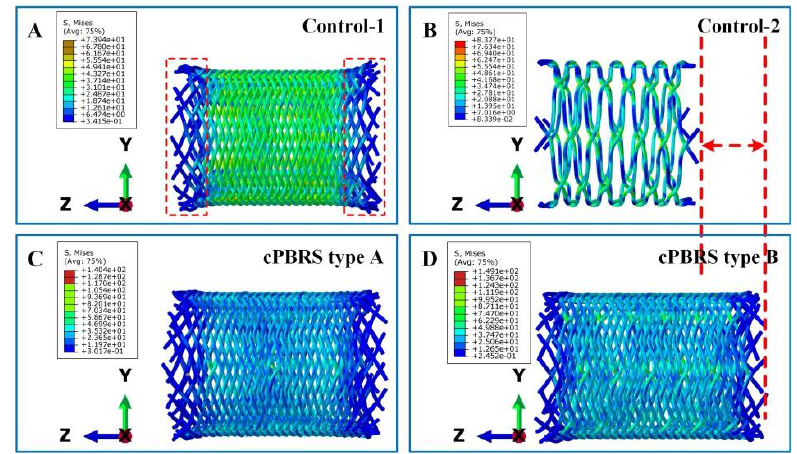
Figure 9. The Von Mise distribution of different prototypes after balloon-expanding simulations. ( A ) The Control-1 prototype; ( B ) The Control-2 prototype; ( C ) The cPBRS type A prototype; ( D ) The cPBRS type B prototype.